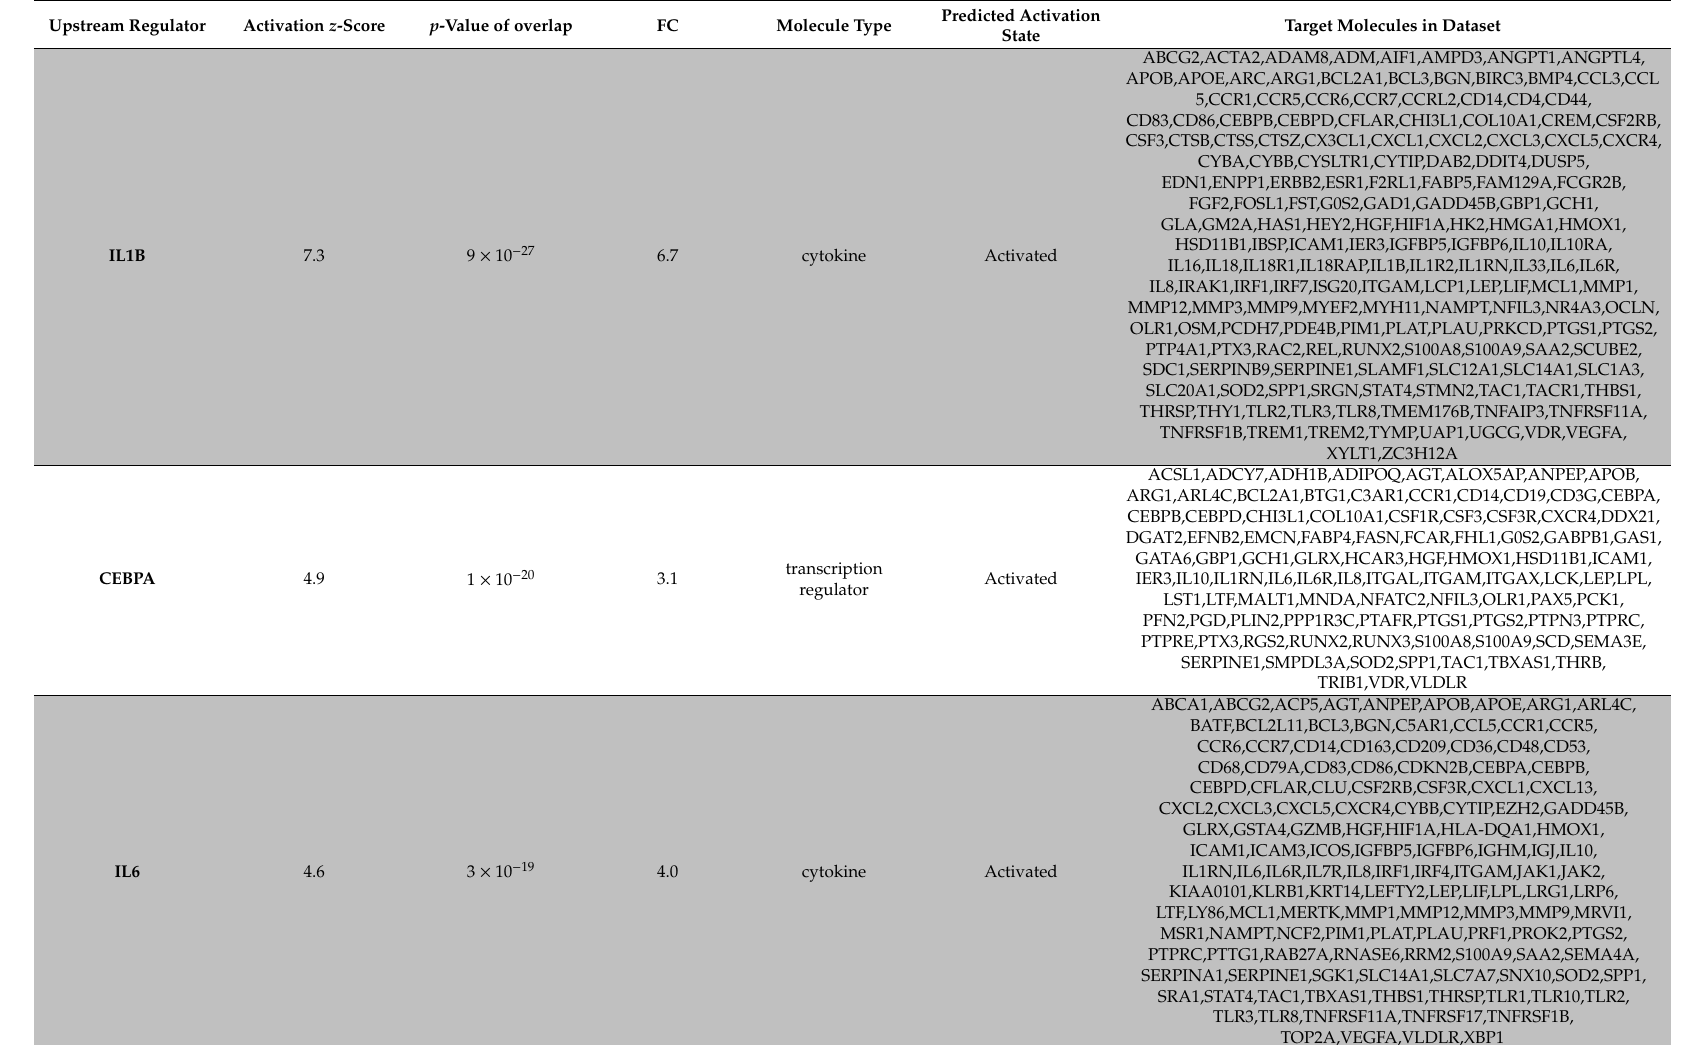
Table 5. List of top 30 upstream regulators (AAA gene list, part 2), predicted to be significantly di ff erent between AAA and AOD (z-score => 2.0; p < 0.01). FC; fold change of these genes in the data set. Target molecules from the data set are depicted on which upstream regulator prediction is